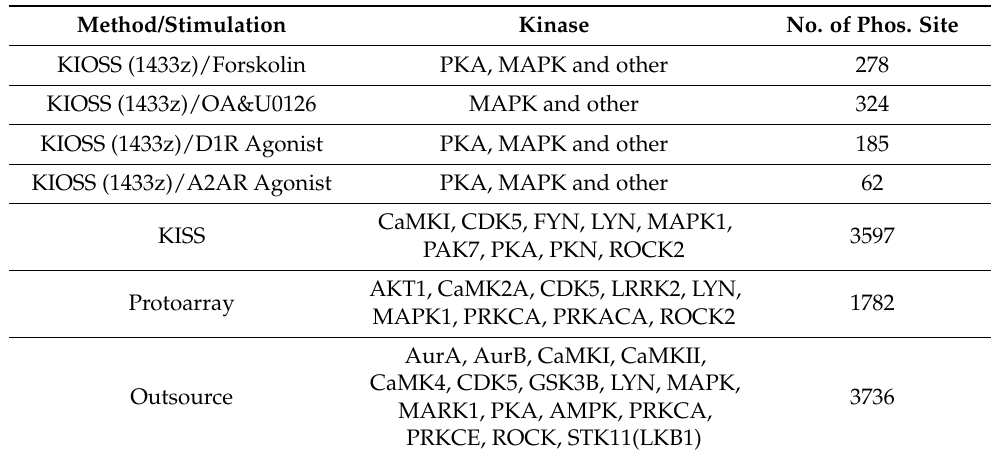
Table 1. Statistics of the KANPHOS